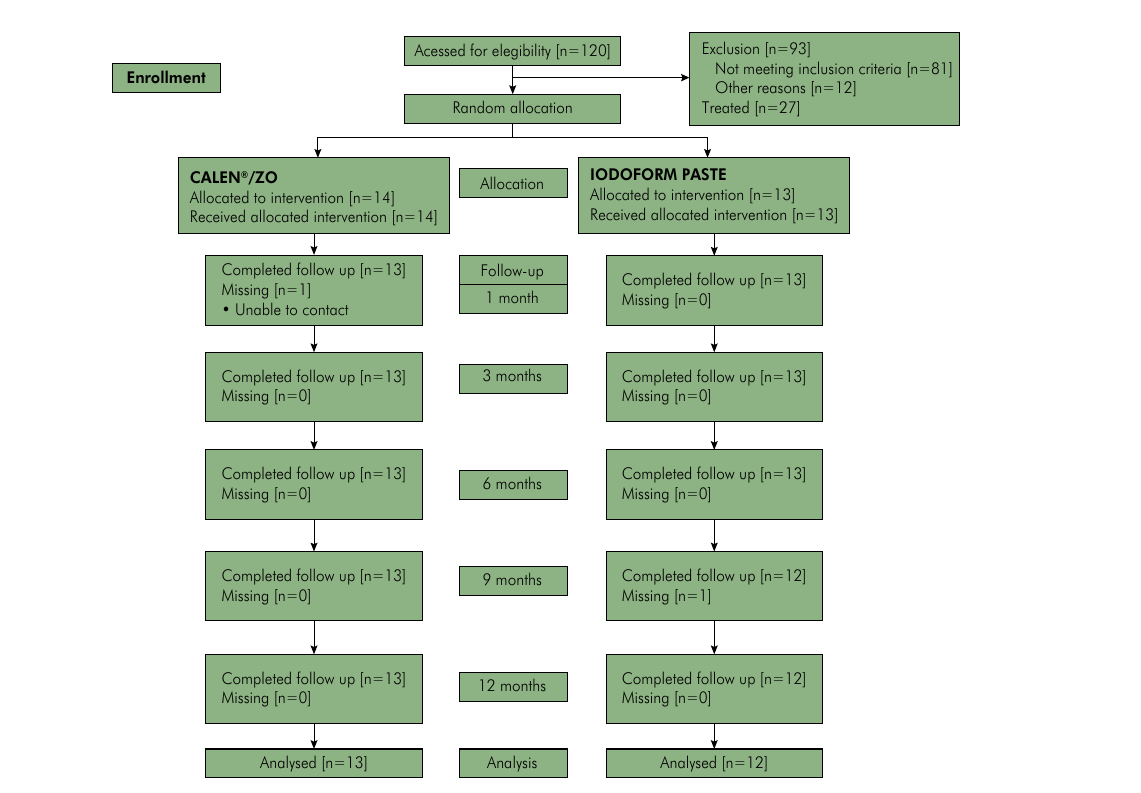
Figure 3. CONSORT